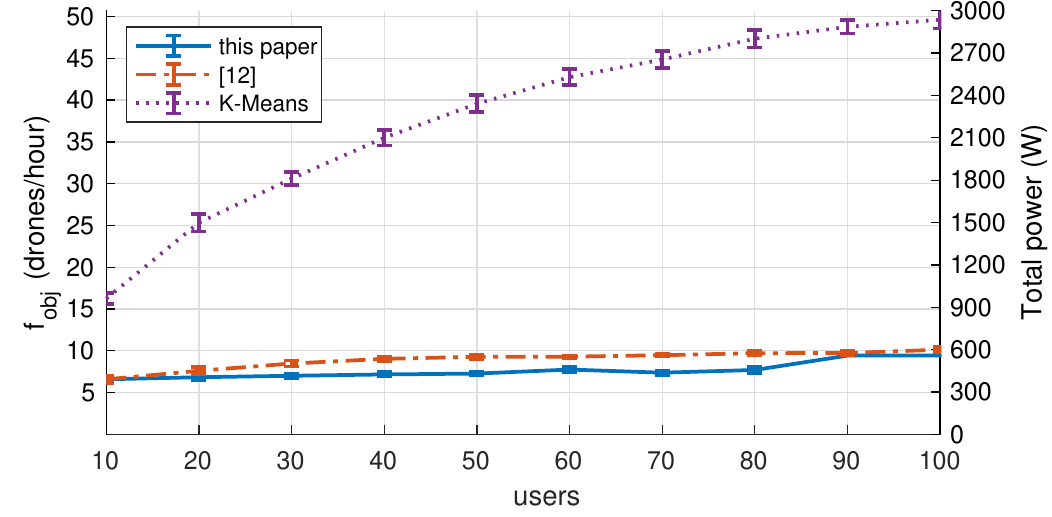
Figure 9. Comparison against other